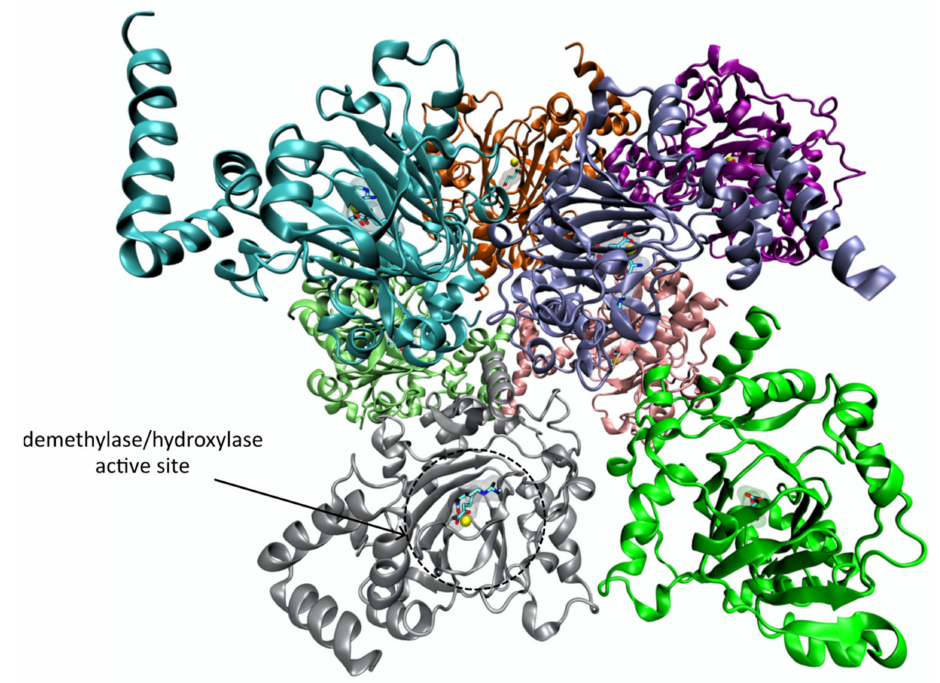
Figure 15. Ribbon representation of the human Jmjd6 enzyme with the PDB ID 6MEV [137] obtained with VMD. The Jmjd6 active site harbors a catalytic Fe (II) ion (colored in yellow), one molecule of mono-Methyl Arginine and one molecule of 2-oxoglutaric acid. All ligands are represented in